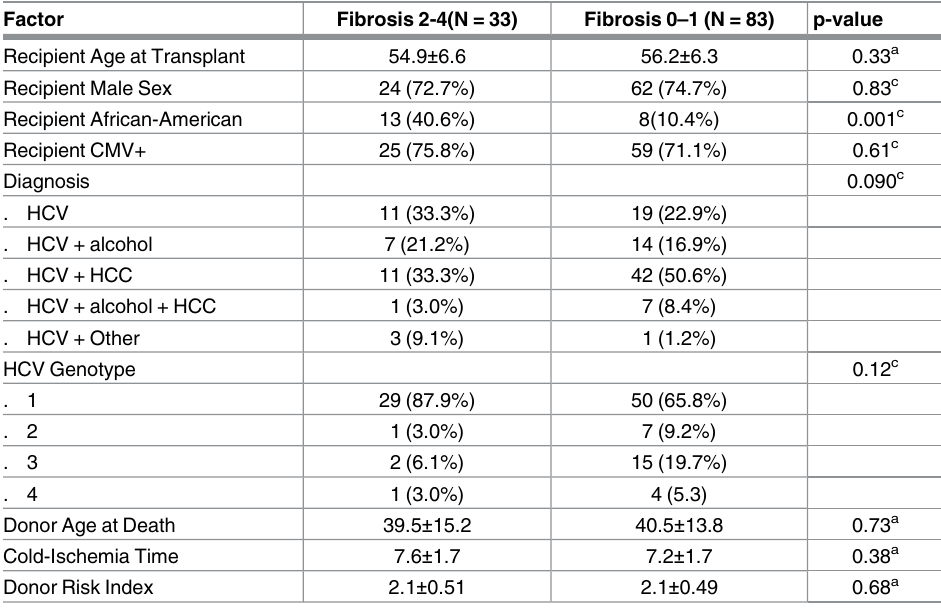
Table 1. Patient